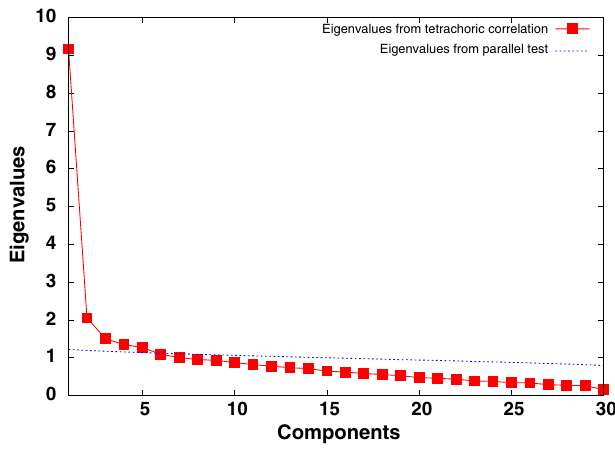
FIG. 1 (color online). The eigenvalues of the tetrachoric cor- relation matrix are depicted in decreasing order together with the eigenvalues of correlation matrices generated from random un- correlated standardized normal variables. This figure graphically illustrates the parallel analysis method and suggests that we should look for a five-factor model of the FCI data.